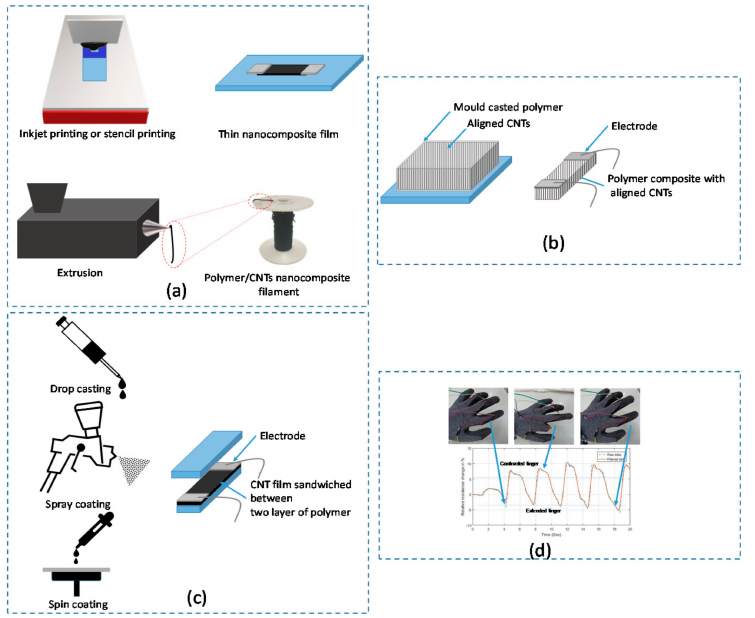
Figure 6. Different sensors architecture, deposition techniques and potential application ( a ) Strain sensor based on randomly oriented CNTs, ( b ) sandwiched CNTs based strain sensor ( c ) strain sensor based on aligned CNTs and ( d ) potential of filament strain sensors for wearable